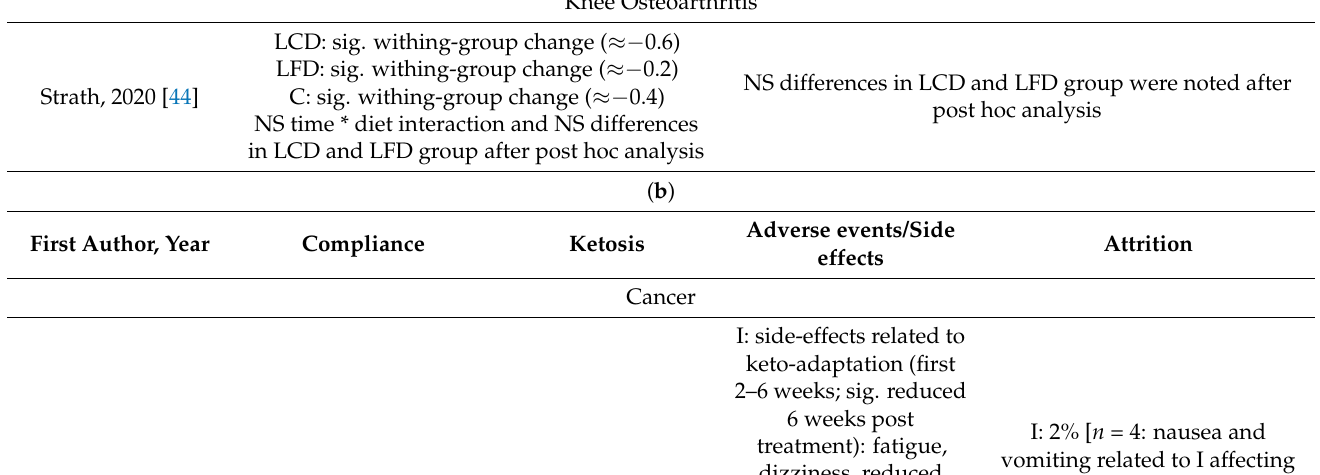
Table 2. Cont. Knee